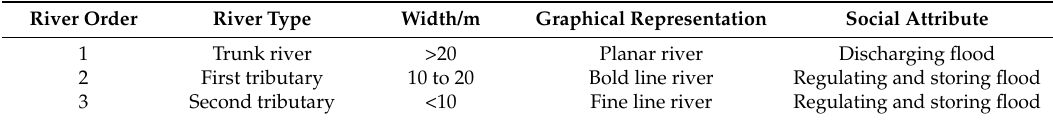
Table 1. River systems were graded according to the width and social